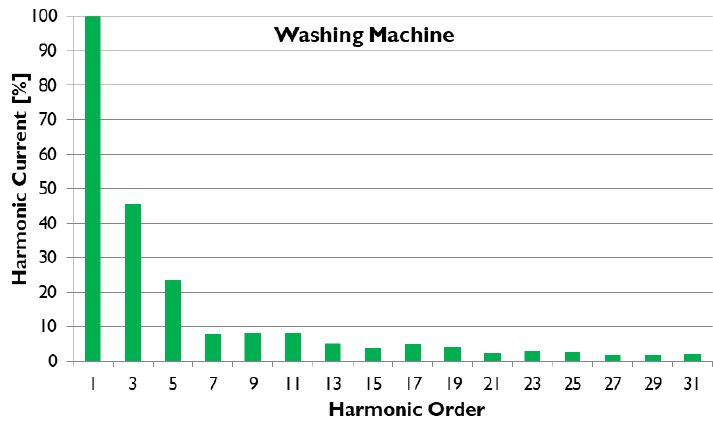
Figure 4. Current spectrum of the washing machine.